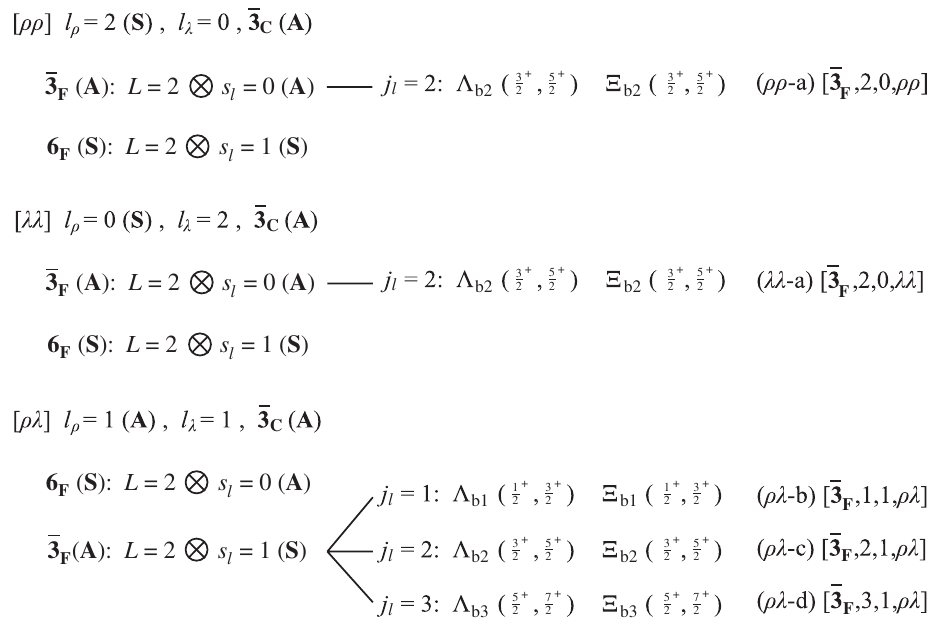
Figure 1. Categorization of D -wave bottom baryons belonging to the SU ( 3 ) flavor ¯3 F